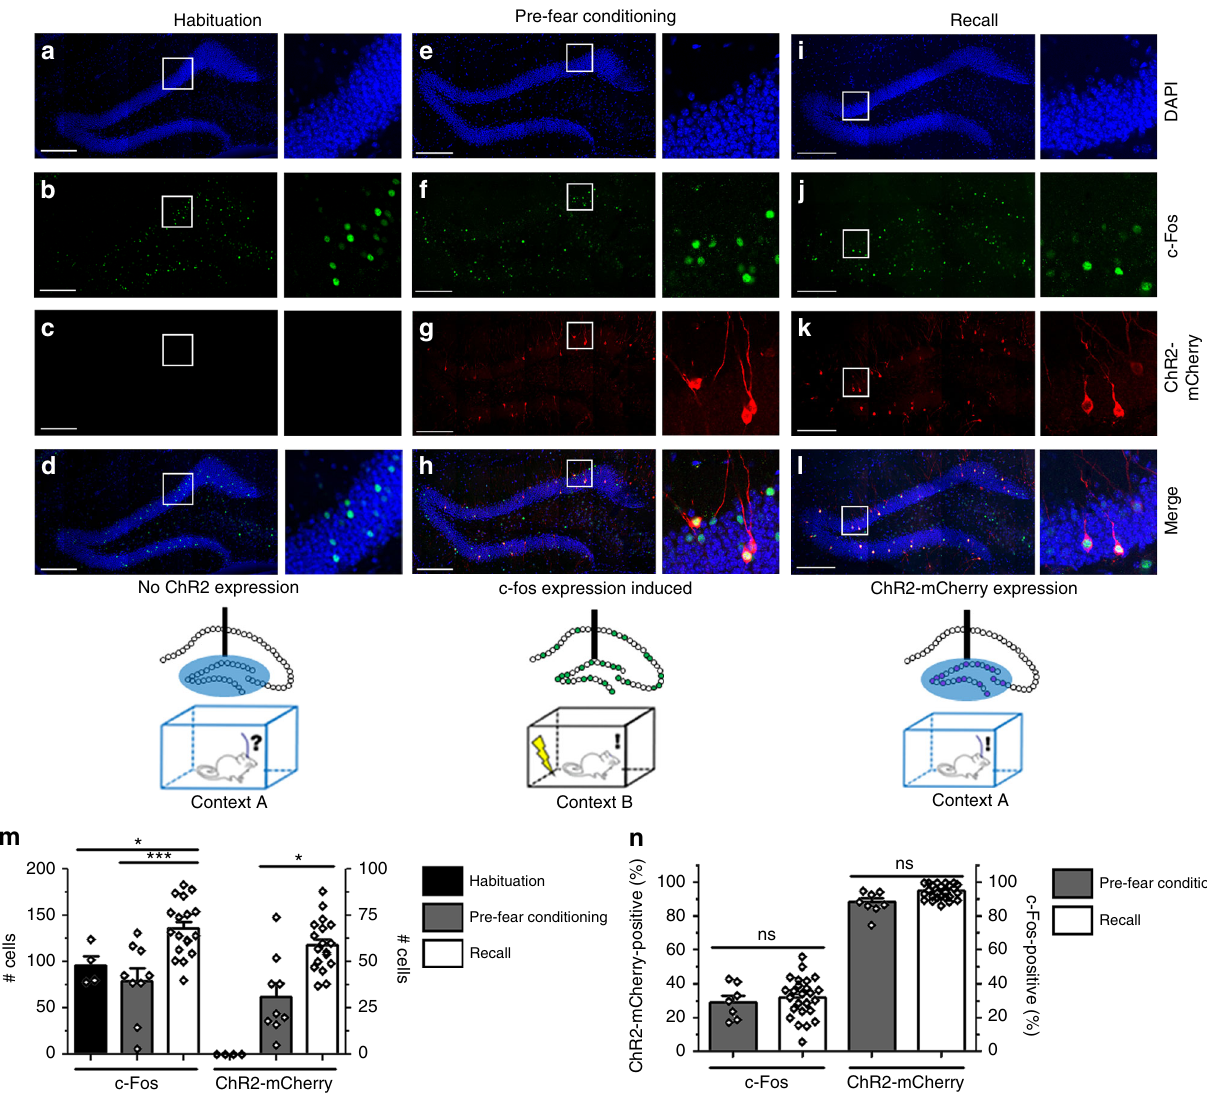
Fig. 2 Expression of ChR2-mCherry and c-Fos in c-fos-tTA/TRE-ChR2 optogenetics model. a – l Timeline of ChR2-mCherry expression. Mice are trained through CFC and sacri fi ced at the following points: after habituation ( a – d ), after 2 d Dox withdrawal, pre-fear conditioning ( e – h ), and after recall ( i – l ). The rectangular area in a – l is magni fi ed to demonstrate localization of ChR2-mCherry and c-Fos in representative neurons. m Number of DG granule neurons in sections near the injection site expressing endogenous c-Fos and ChR2-mCherry (one-way ANOVA, n = 4, 9, 16 per group). n . Co-expression of c-Fos and ChR2-mCherry after 2 d Dox withdrawal (Pre-Fear Conditioning), and after Recall (one-way ANOVA, n = 4, 9, 16 per group). Scale bar for fl uorescent images: 200 µ